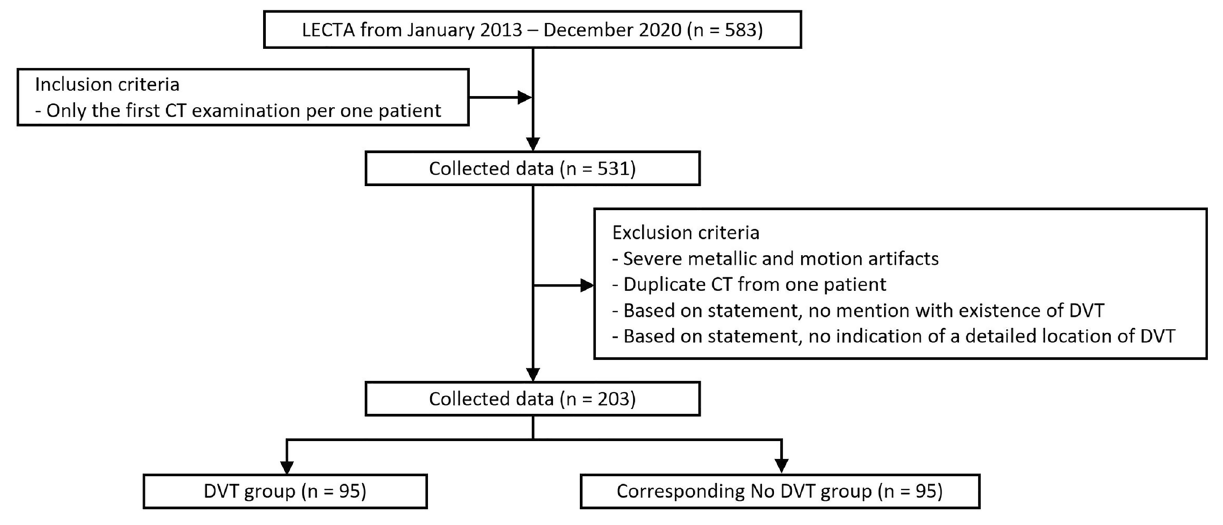
Figure 1. Flowchart of data